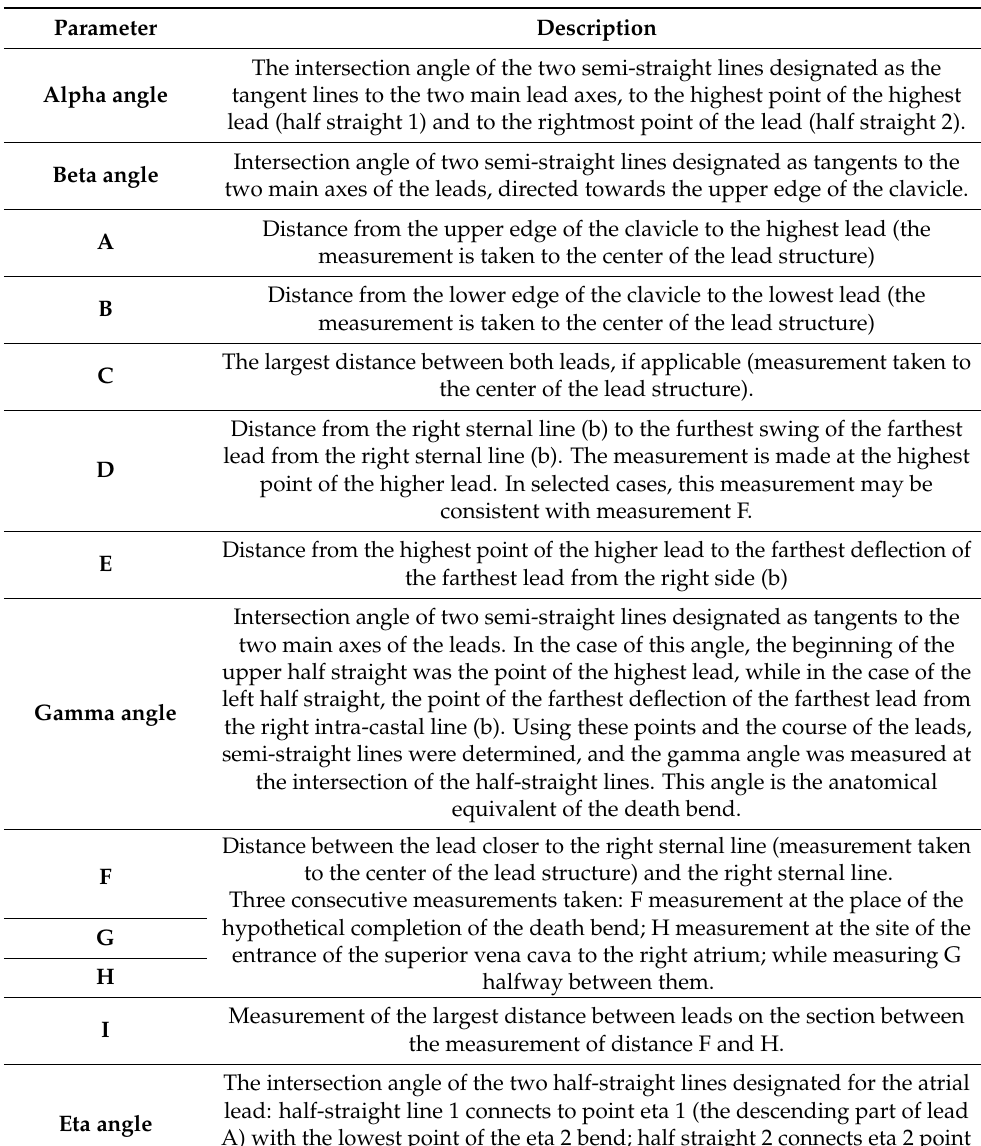
Table A1. Description of the parameters proposed for evaluation of intra-cardiac